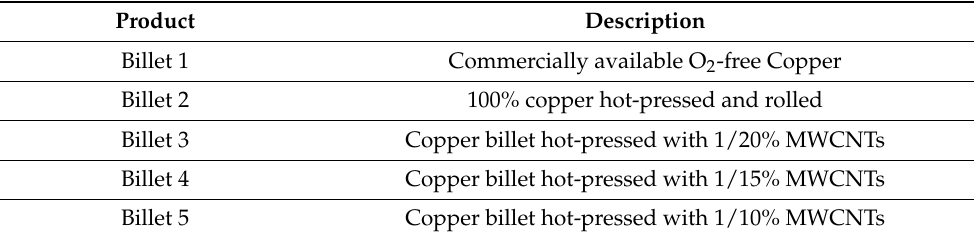
Table 1. List of Billets and the Concentration of